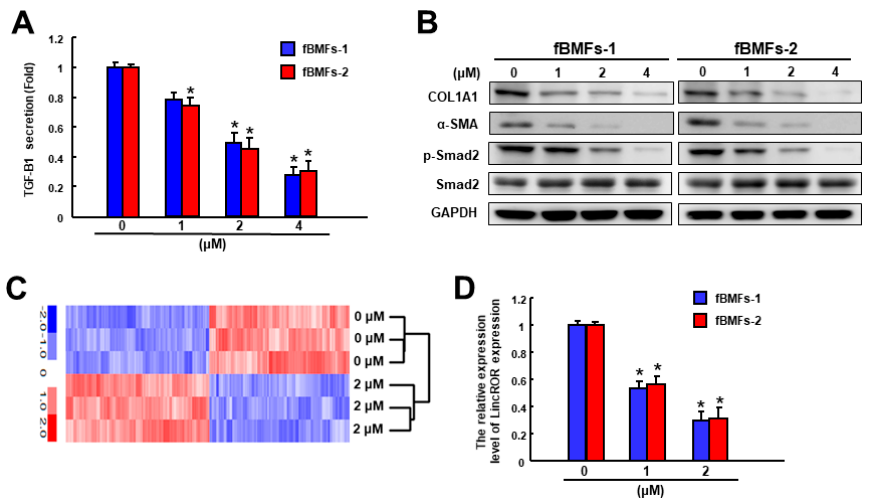
Figure 3 . α -mangostin suppresses the expression of fibrosis markers, components of TGF- β signal- ing, and LincROR in fBMFs. ( A ) α -mangostin dose-dependently downregulated the secretion of TGF- β 1 in fBMFs. ( B ) The protein expression levels of fibrosis (type I collagen) and myofibroblast markers ( α -SMA) were dose-dependently downregulated along with the reduced phosphorylation of Smad2 by western blot. ( C ) The lncRNAs expression level of LincROR in the α -mangostin-treated fBMFs were analyzed by a high-throughput RNA sequencing approach. ( D ) qPCR analysis was applied to analyze the relative LincROR expression level in α -mangostin treated fBMFs. ∗ p < 0.05 compared to the control.